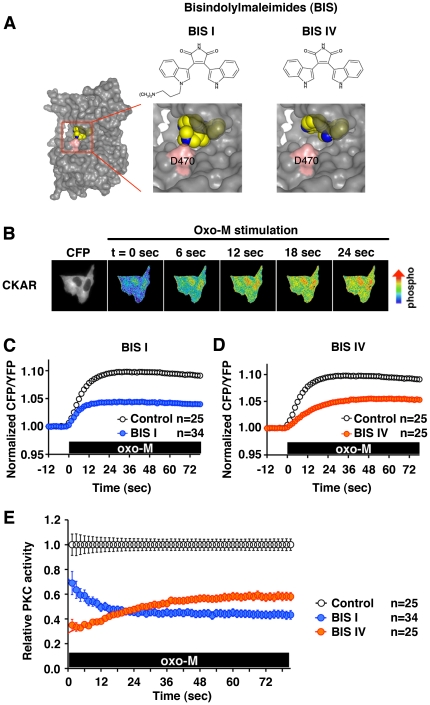
Two BIS compounds show distinct time-dependent changes in potency affecting cellular PKC activities.(A) Molecular structure of bisindolylmaleimide I (BIS I, left) and bisindolylmaleimide IV (BIS IV, right). Lower panels show molecular models for BIS bound PKCβII modified from the PDB file (2I0E). Carbon (yellow), nitrogen (blue) in BIS compounds are shown as spheres. The key residue for the substrate recognition, D470, is highlighted in pink. (B) CHO cells expressing CKAR were stimulated with 3 µM oxotremorine-M (oxo-M) at t = 0. Fluorescent signals from cells from the CFP channel are shown (far left). Oxo-M application induces phosphorylation of CKAR and a change in the CFP/YFP fluorescent ratio of the CKAR probe, shown as pseudocolor images. Images from indicated times are shown. (C) Cellular PKC activities in the presence (blue) or absence (white) of 200 nM BIS I. The black box indicates the presence of oxo-M. (D) Cellular PKC activity in the presence (orange) or absence (white) of 1 µM BIS IV. (E) Relative PKC activity in the presence of BIS I (blue) or BIS IV (orange) normalized to the PKC activity without inhibitors (white) derived from (C) and (D).